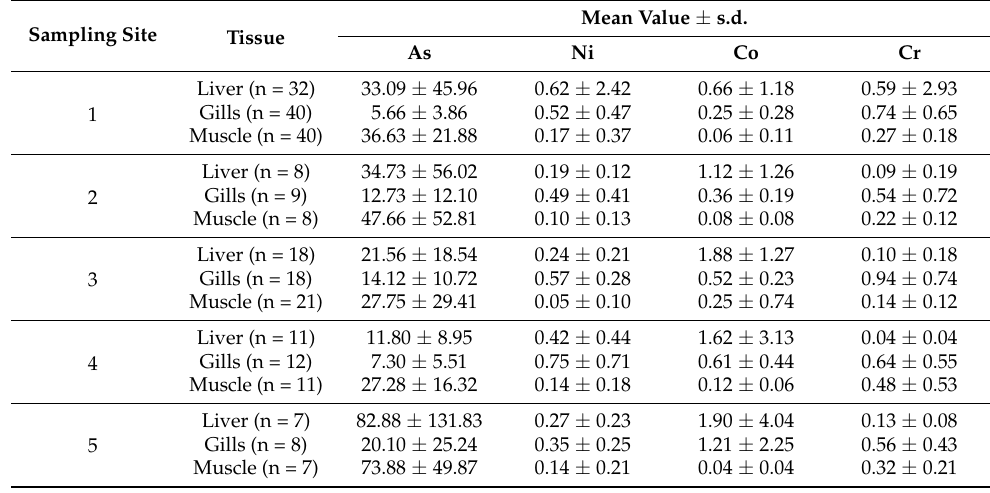
Table 4. Average metal concentration in fish and standard deviation at each sampling site (mg/kg).